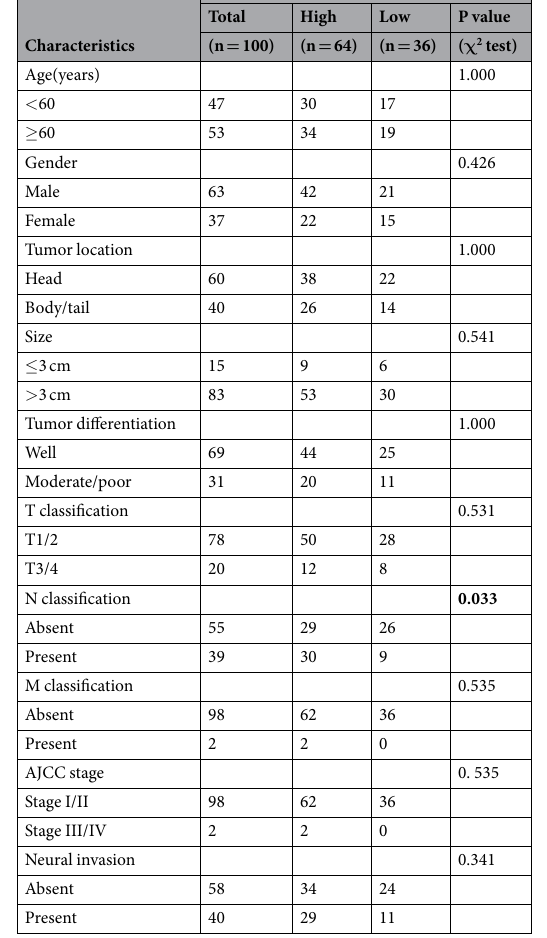
Table 1. Correlations of WNT7A with clinical characteristics in PDAC patients. AJCC staging is according to the 7 th edition of the American Joint Committee on Cancer (AJCC) staging system. The bold number represents the p-values with significant differences. P value was calculated by χ 2 test or Fisher’s exact